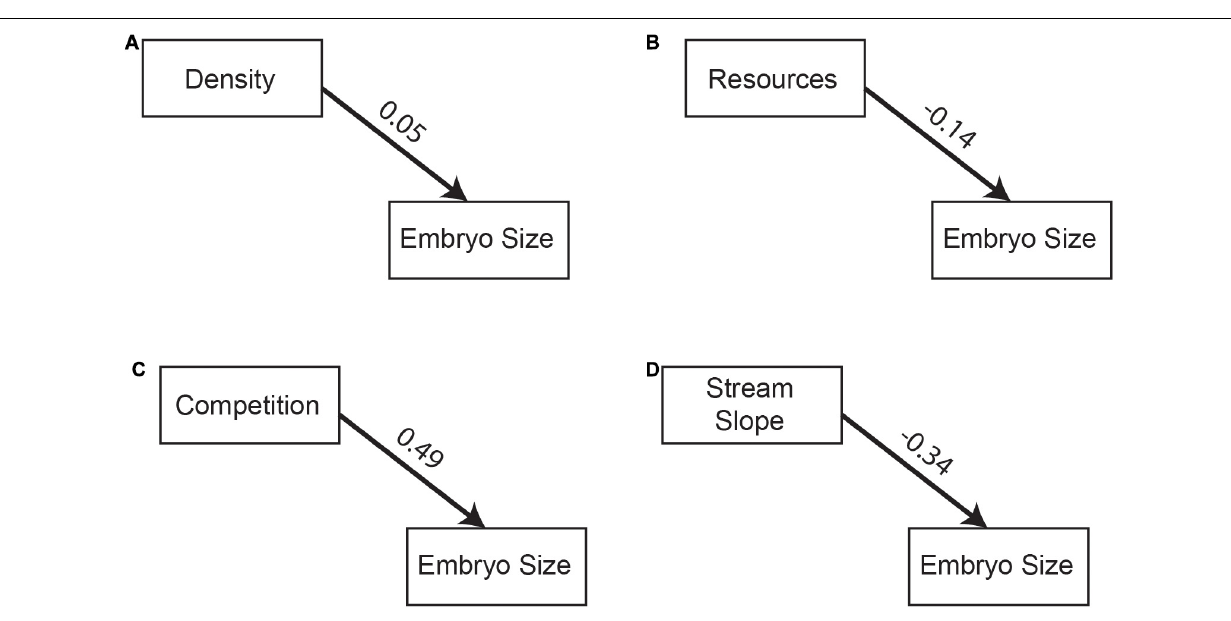
FIGURE 5 | Path diagrams of best models for embryo size showing (A) population density, (B) resource availability, (C) competition, and (D) stream slope as direct effect on embryo size. Path diagram shows model-averaged standard total effect above the path